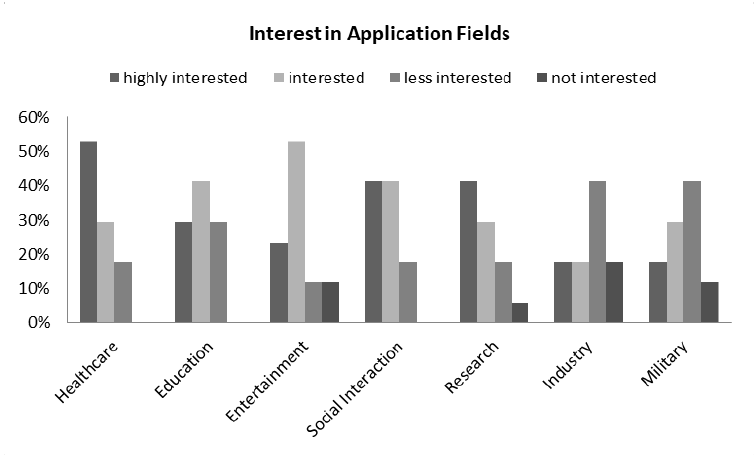
Fig. 2. Interest in application